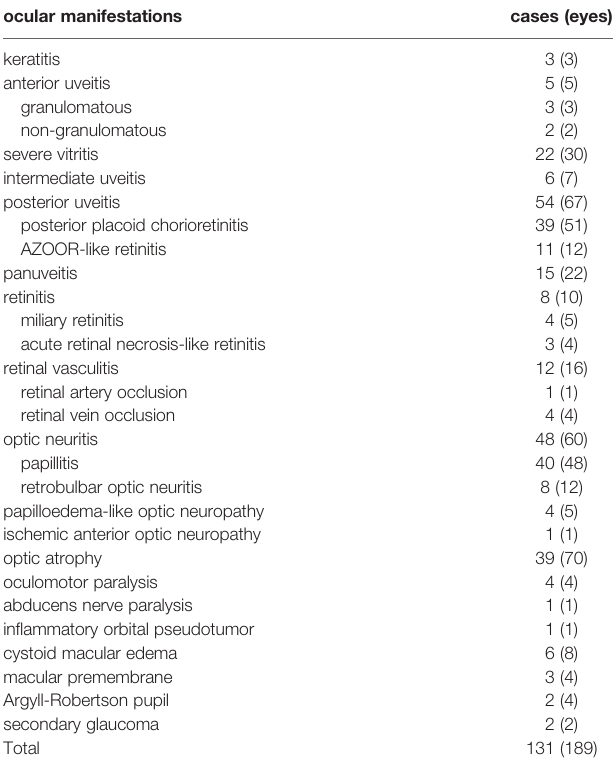
TABLE 1 | Clinical manifestations of ocular